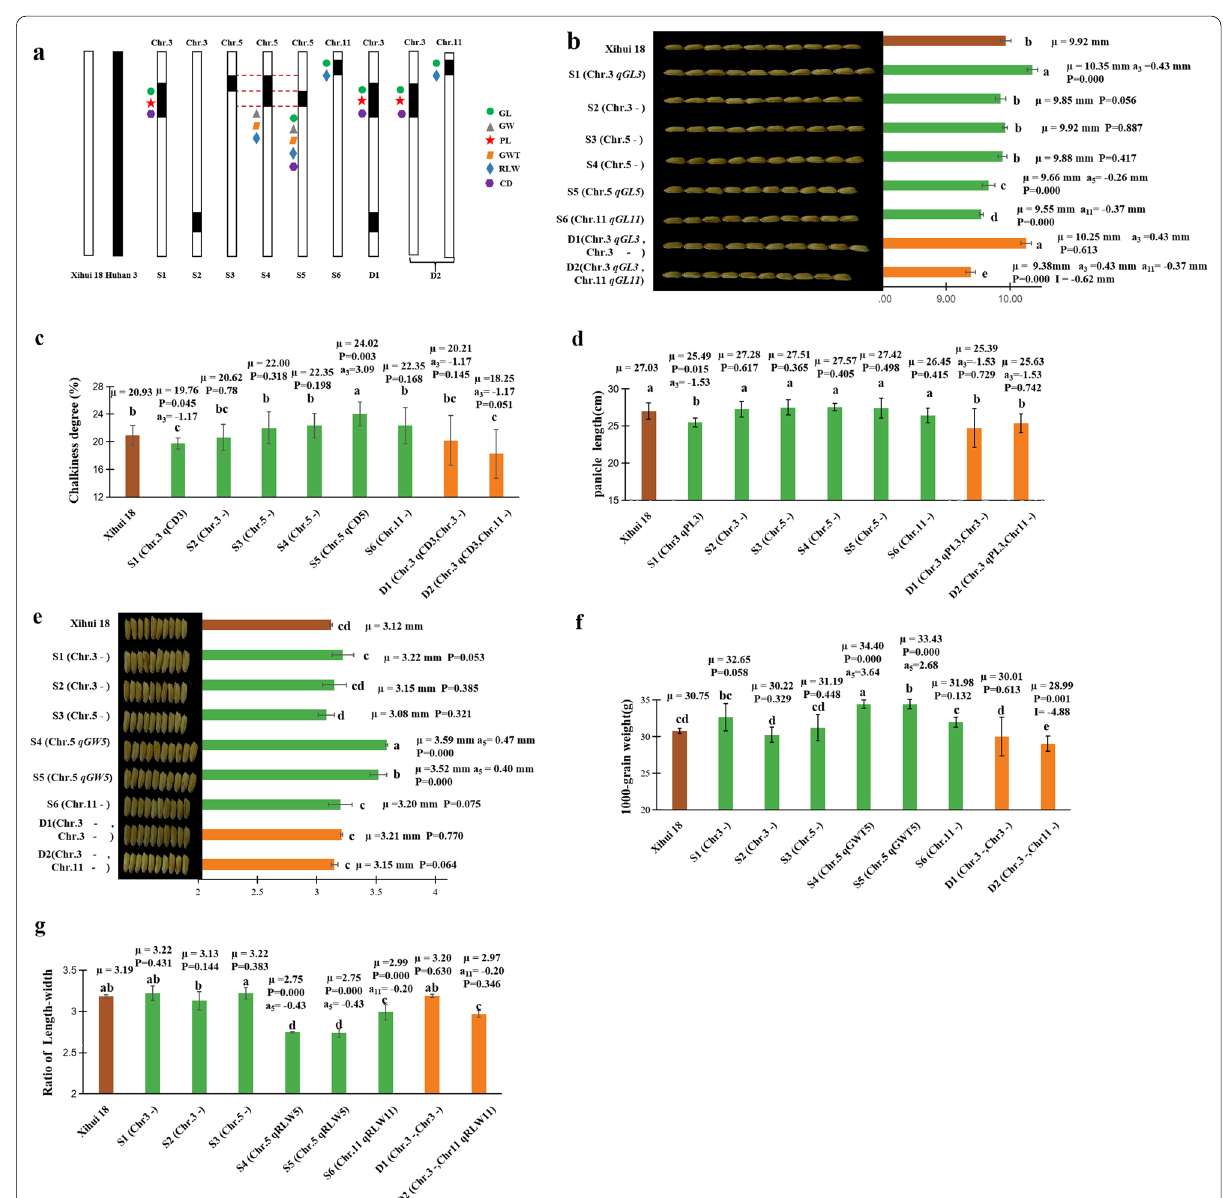
Fig. 4 Additive and epistatic effects of QTL for related traits in the SSSLs and DSSLs. a Diagram of the locations of substitution segments and QTL in S1–S6 and D1 and D2. b – f Parameters of QTL in different SSSLs and DSSLs, including grain length ( b ), degree of chalkiness ( c ), panicle length ( d ), grain width ( e ), 1000-grain weight ( f ), and ratio of grain length to width ( g ). Different lowercase letters indicate a significant difference ( P < 0.05), as determined by Duncan’s multiple comparison. μ: the average value of each line; ai: additive effect for each QTL controlling the trait, whose positive value shows allele from substitution segment increasing phenotypic value, while negative value decreasing one. I: epistatic effect between QTL. P < 0.05in SSSL indicates that a QTL existed in the substitution segment of the SSSL, as determined by one-way ANOVA and LSD multiple comparison with Xihui 18; P < 0.05 in DSSL indicates that an epistatic effect of Q1 Q2 existed in DSSL, as detected by two-way ANOVA. S1 (Chr. 3 × RM3417 (6.1 Mb)–RM3766 (7.4 Mb)-RM14809 (11.7 Mb)–RM7425 (13.0 Mb)); S2 (Chr. 3 RM5813 (35.2 Mb)–RM3346 (37.6 Mb)–RM1221 (40.1 Mb)); S3 (Chr. 5 RM2010 (1.2 Mb)–RM405 (3.3 Mb)–RM5874 (3.7 Mb)); S4 (Chr. 5 RM2010 (1.2 Mb)–RM405( 3.3 Mb)-RM5874 (3.7 Mb)-RM3322 (4.4 Mb)– RM3328 (5.6 Mb)); S5 (Chr. 5 RM405 (3.3 Mb)–RM5874 (3.7 Mb)-RM3322 (4.4 Mb)–RM3328 (5.6 Mb)); S6 (Chr. 11 RM26038 (1.3 Mb)–RM26045